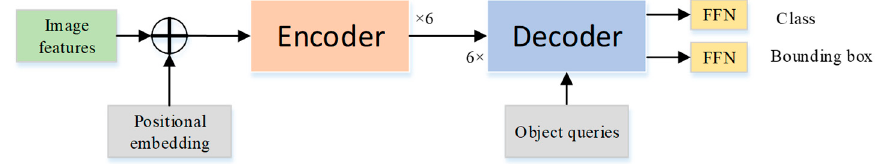
Figure 2. The structure of